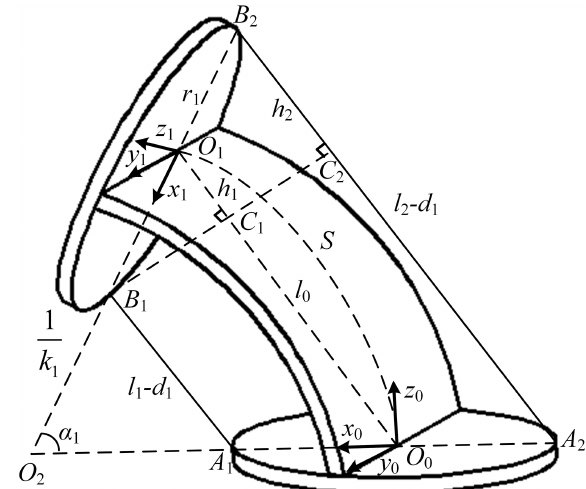
of the driving cables of the second bending section between the top plane of the lower connector and the top plane of the upper connector of the first bending section.